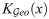
Histogram of complexity KGeo(x).Histogram of complexity for sequences x with |x| = 8.